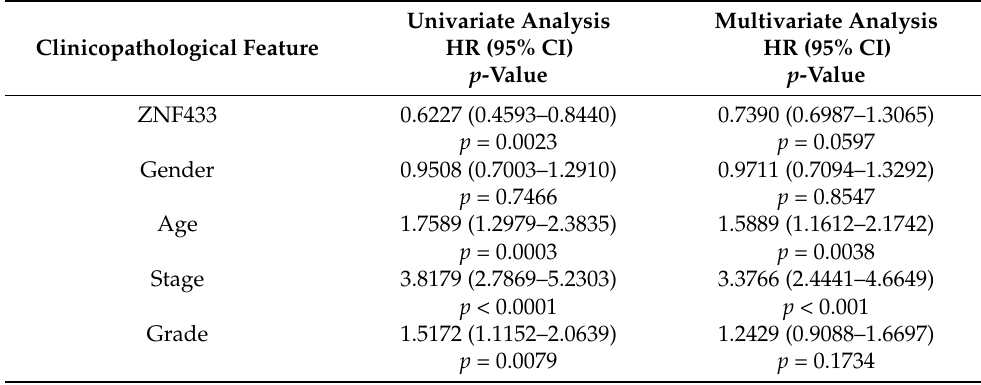
Figure 3. ( a ) Overall survival of patients with clear-cell and papillary renal cell carcinomas as a function of ZNF433 ex- pression. The Kaplan–Meier survival plots were generated using K-M plotter analysis (https://kmplot.com/analysis, ac- cessed on 7 May 2021) of RNAseq data from the clear-cell renal cell carcinoma ( n = 533) TCGA datasets. The median survival for the high-expression group was 118.47 months, compared to 54.2 months for the low-expression group. ( b ) Receiver operating characteristic (ROC) curve of overall survival times of ZNF433 low- and high-expression patients. The ROC analysis was performed to validate KM survival observations and to ascertain if ZNF433 expression could discrimi- nate between high-expression and low-expression groups in relation to survival. The AUC was 0.701, sensitivity = 0.66, specificity= 0.66, and 95%CI = 0.67–0.729 with p < 0.001. Table 2. Univariate and multivariant Cox regression analysis of age, gender, pathological stage, histological grade, and pathological N in relation to overall survival in ccRCC patients. The statis- tical significance was set at p < 0.05.